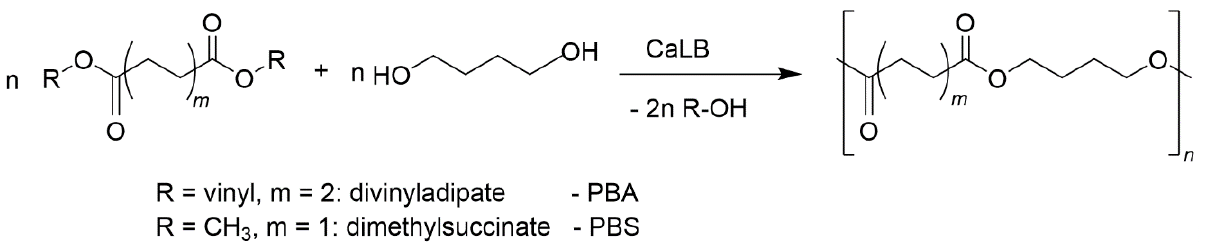
Figure 2. Reaction scheme for the enzymatic polycondensation of dicarboxylic esters with 1,4-butanediol.